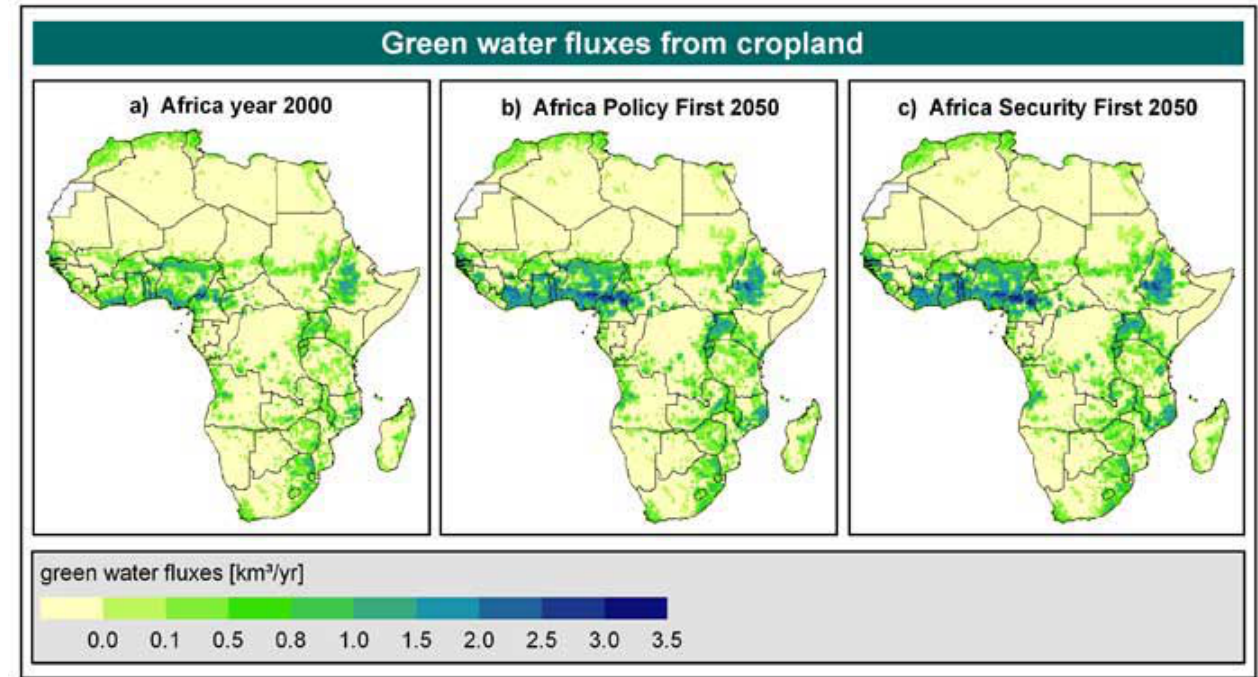
Figure 2. Green water fluxes from cropland in Africa for (a) the year 2000, (b) the GEO-4 “Policy First” scenario in 2050, and (c) the “Security First” scenario in